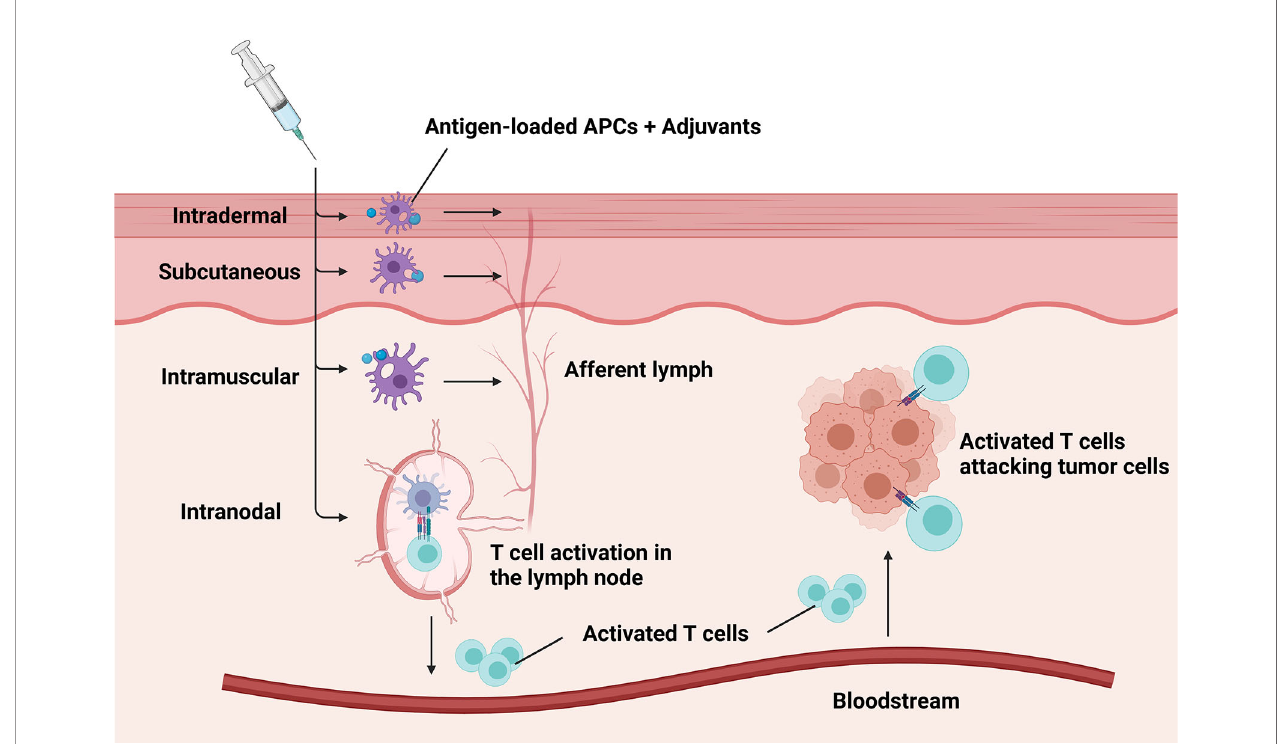
FIGURE 3 | Different administration routes of breast cancer vaccines. Major administration routes of breast cancer vaccines include intradermal, subcutaneous, intramuscular, and intranodal injection. The preferred routes depending on the type of the delivered antigens help effectively present the antigens to autologous antigen-presenting cells (APCs). Then the antigen-loaded APCs transfer to lymph nodes to prime T cells through afferent lymph. Subsequently, activated T cells transport into tumorous tissue with the aid of the bloodstream to eradicate tumor